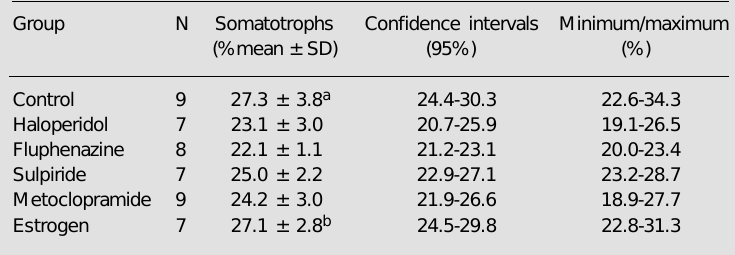
Table 1 - Percentage of immunoreactive somatotrophs in rat anterior pituitaries, in the absence of treatment and under estrogen or dopamine receptor antagonist treatment. a P<0.05 compared to haloperidol, fluphenazine and metoclopramide (ANOVA). b P<0.05 compared to haloperidol and fluphenazine (ANOVA).